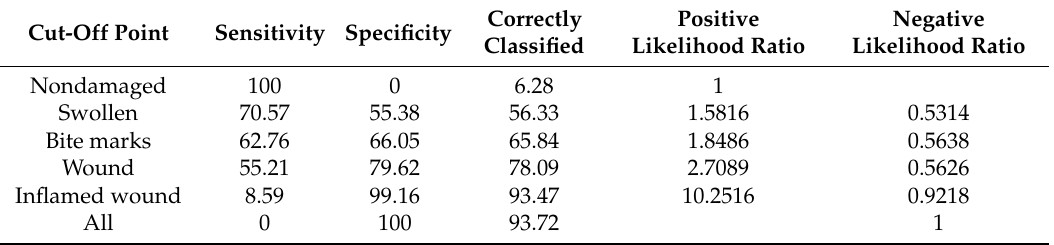
Table 5. Receiver operating characteristic (ROC) analysis for quantifying the accuracy of tail posture in identifying tail